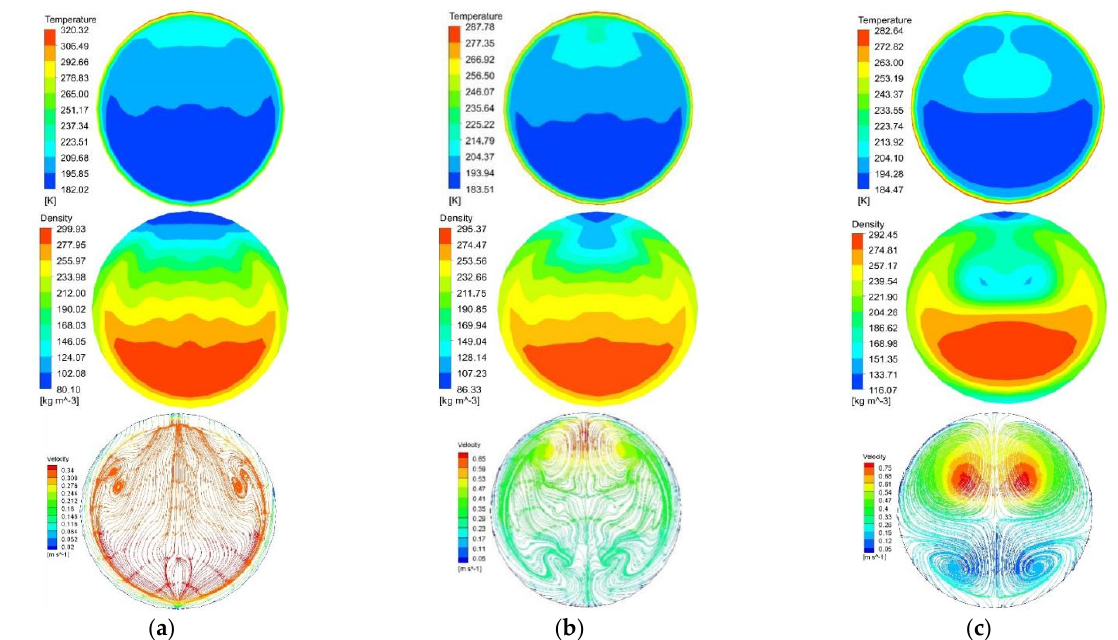
Figure 7. Temperature, density, and secondary flow trace contours on the cross section of the bend at different angles: ( a ) α = 0°, ( b ) α = 60°, and ( c ) α = 120°.